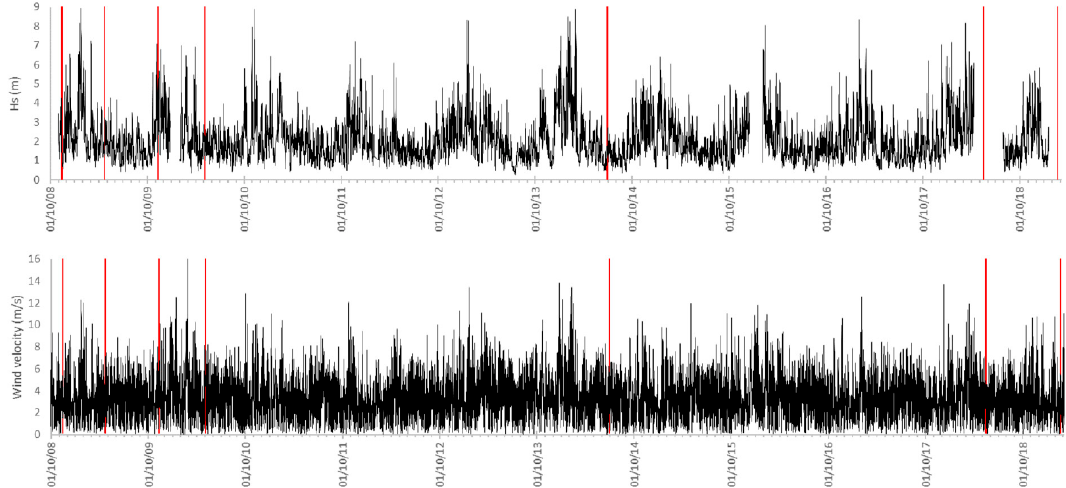
Figure 2. Significant wave heights (Hs) measured at the Leixões wave buoy and estimated wind velocities for the study area during the study period; survey dates are marked with red vertical lines.